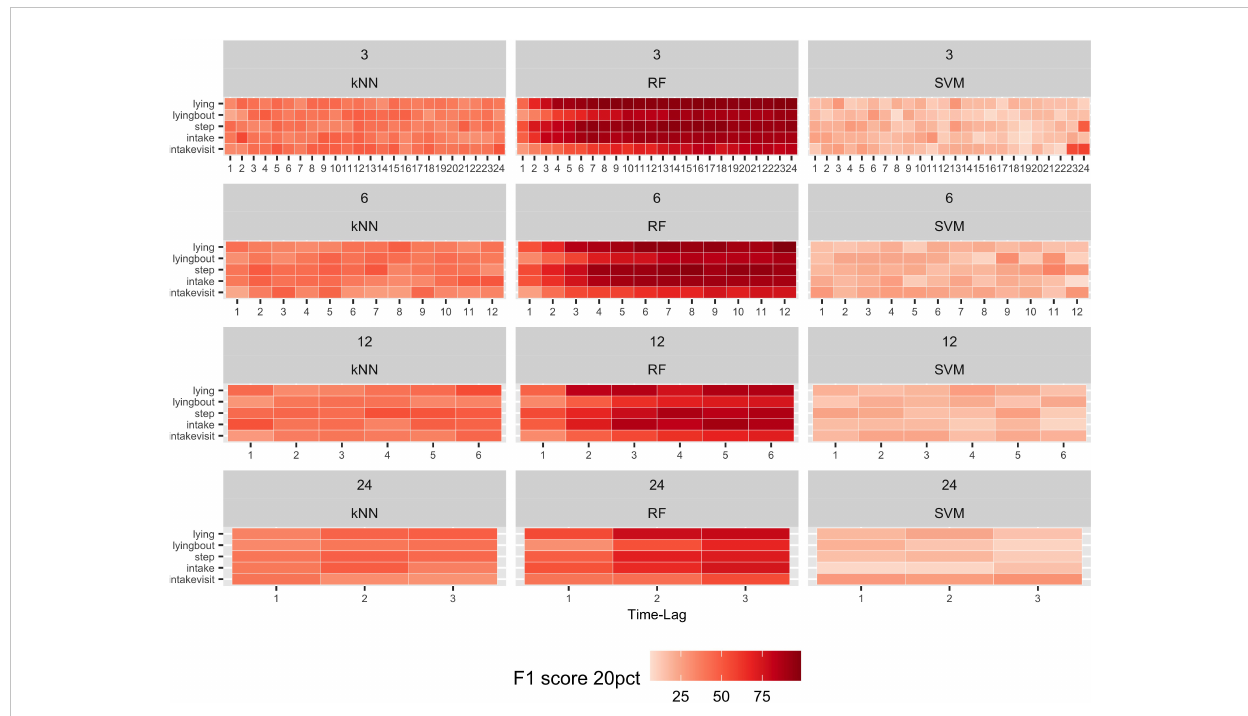
FIGURE 5 F 1 scores (%) using the 20% highest class probabilities as cut-off when sensor data registered by a leg-attached 3-axis accelerometer (TrackaCow, ENGS, Hampshire, UK) were aggregated using time windows of 24, 12, 6, and 3 hours. F 1 scores are shown for those models where all sensor data were used to fi t the models and parity was not taken into account. F 1 scores are shown for different time-lags and for each one of the classi fi ers: k -nearest neighbors ( k -NN), random forest (RF), and support vector machine